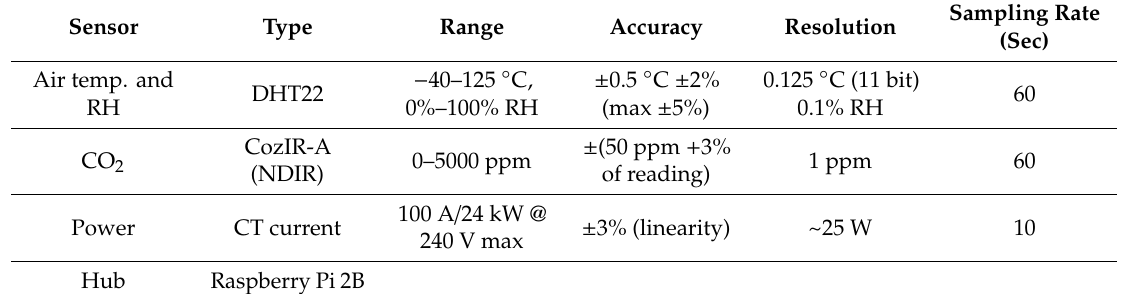
Figure 5. Layout showing sensor location for the ground floor, 1st floor, and 2nd floor for Villa 1.